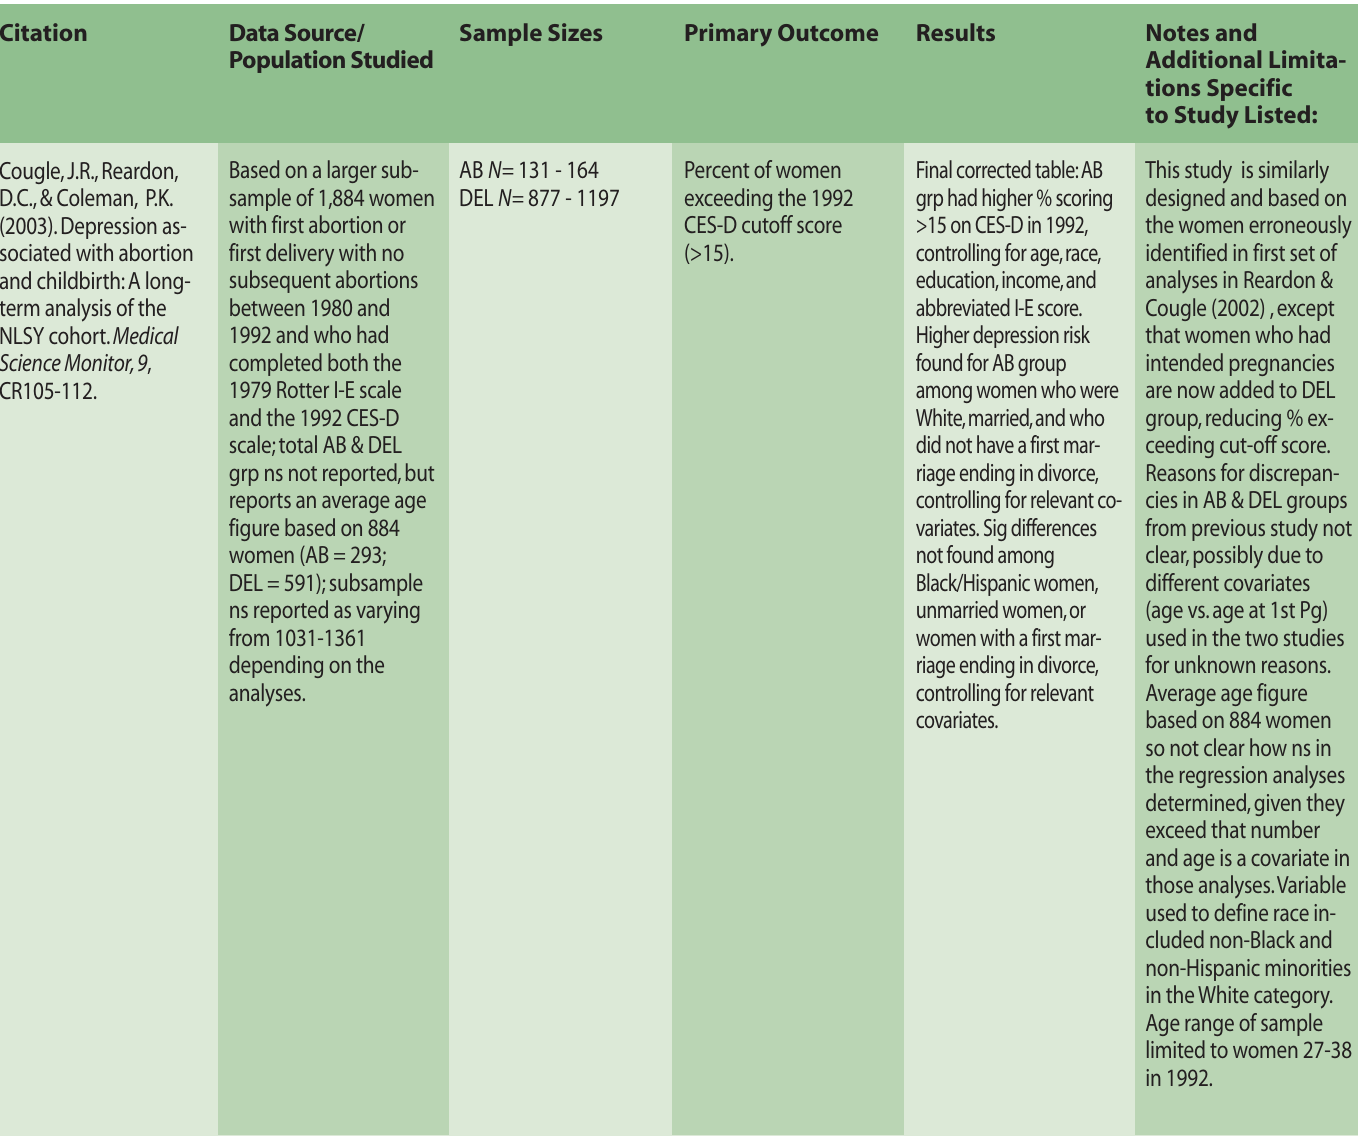
Table 2: Secondary Analyses of Survey Data–Abortion vs.Comparison Groups U.S.STUDIES